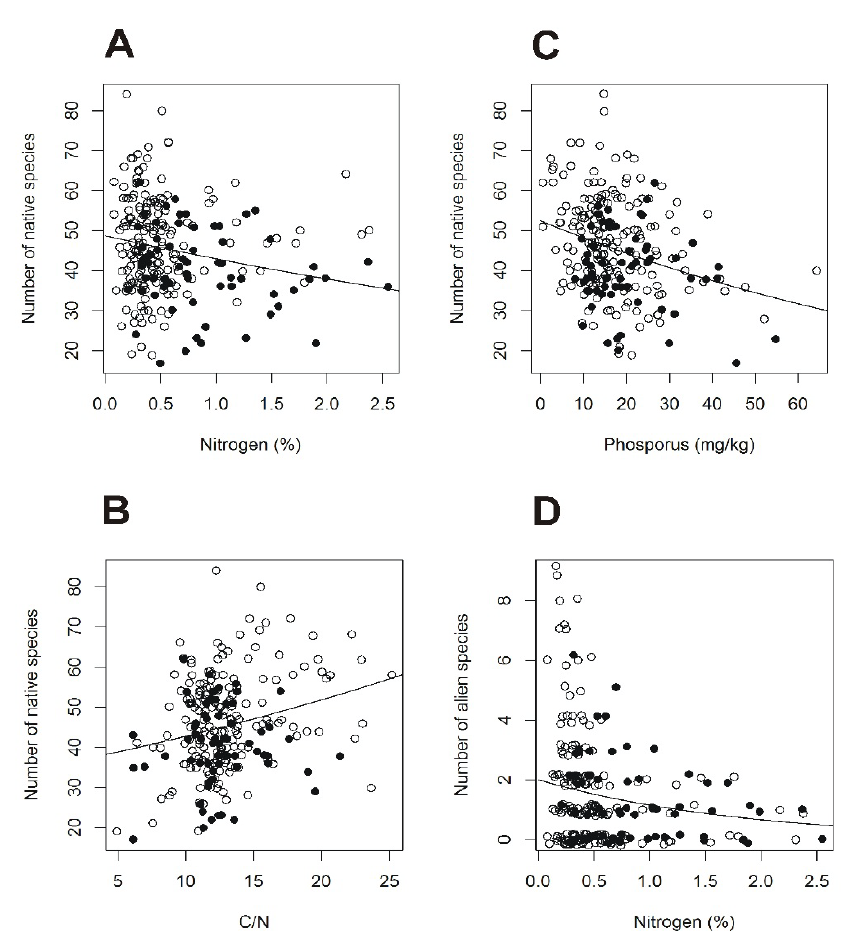
Figure 2. Relationship between species richness of native ( A – C ) and alien ( D ) vascular plants and ecological variables, which were statistically significant in the used model (empty circles—streamside alder forests, full circles—alder